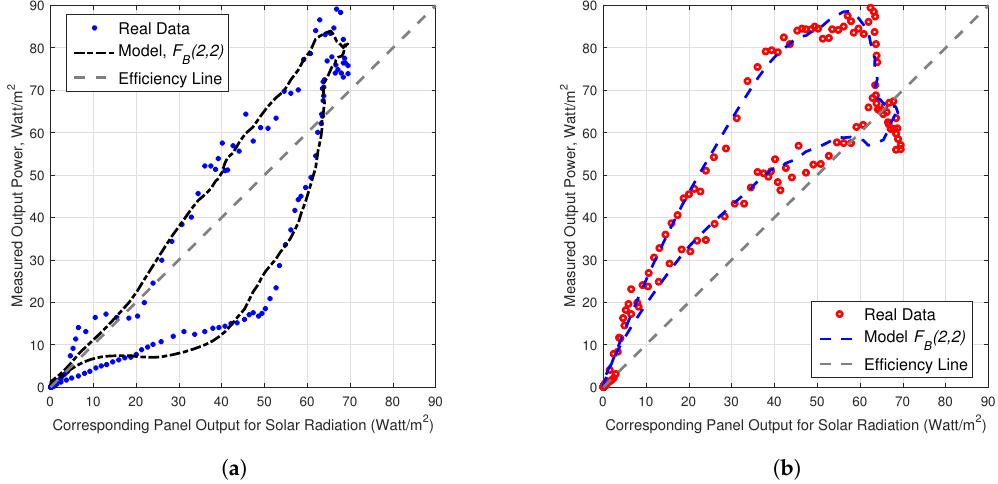
Figure 10. Measured output power value and corresponding panel output for solar radiation for proposed model in F B ( 2,2 ) : ( a ) Fixed system; ( b ) Tracking